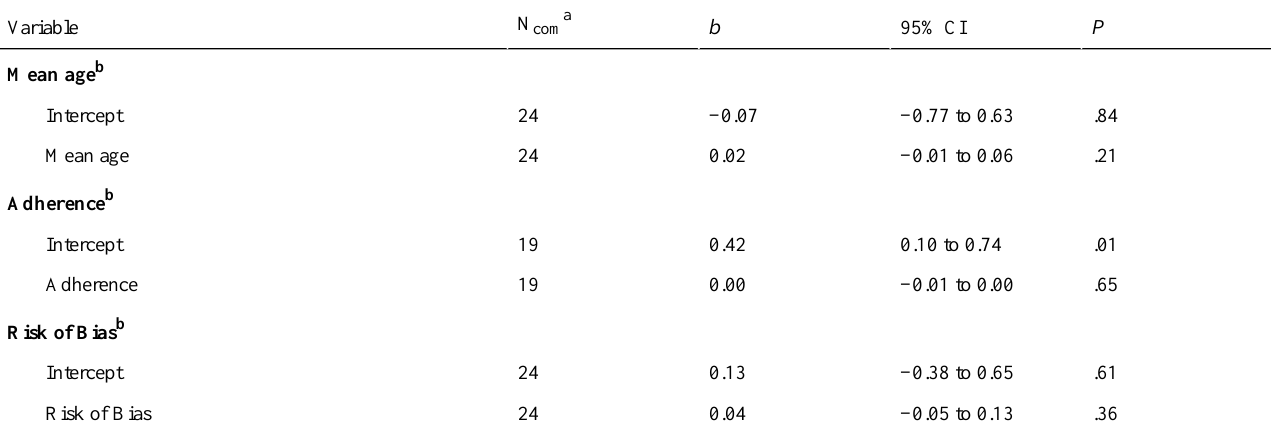
Table 6. Bivariate meta-regression analyses regarding anxiety symptoms in studies comparing computerized cognitive behavior therapy in adolescents and young adults with active treatment and passive controls at posttreatment.